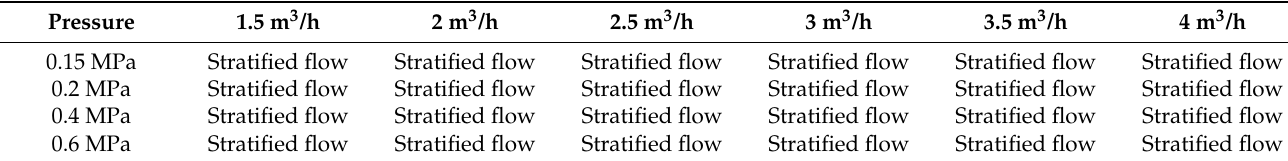
Table 1. Flow patterns of horizontal pipes at different pipe pressures.